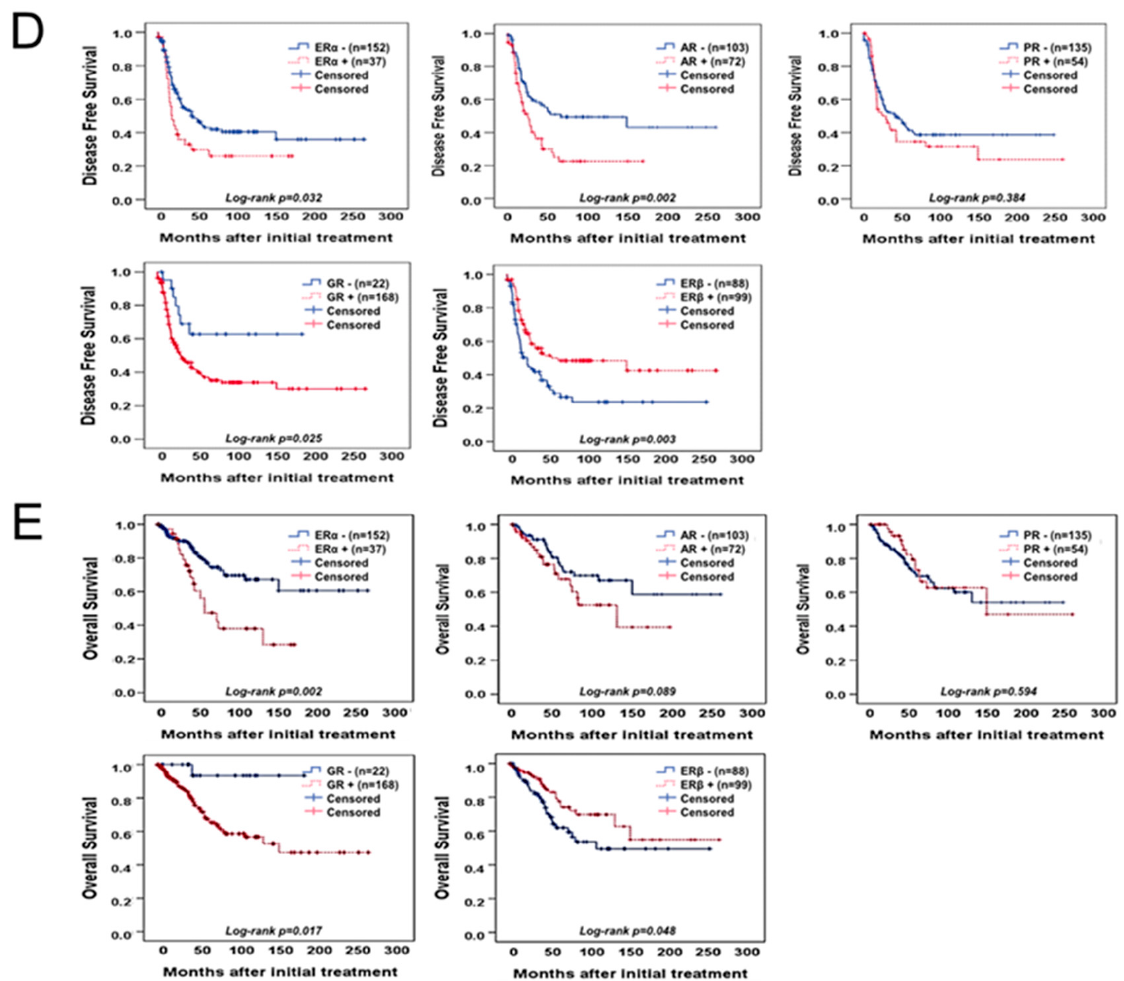
Figure 1. Expression of hormone receptors in EOC tissues. ( A ) Representative immunohistochemical staining images of ER α , AR, PR, GR, and ER β in nonadjacent ovarian epithelial tissues (Normal) and epithelial ovarian cancer (Cancer) tissue samples (scale bar: 50 µ m). ( B ) Boxplots of IHC staining data (histoscores) comparing between nonadjacent ovarian epithelial tissues (Normal) and epithelial ovarian cancer (Cancer) tissue samples of each hormone receptor subtype. Histoscores were calculated based on staining intensity and the area of positive staining ( C ) Publicly available data on the mRNA expression of ER α , AR, PR, GR, and ER β were obtained from the GEO data (GSE26712). A Mann–Whitney U-test or Kruskal–Wallis test was used to compare the mRNA expression level of each hormone receptor. ( D ) The DFS of patients with EOC depends on ER α , AR, PR, GR, and ER β expression. For the DFS analysis, 189 patients with EOC for ER α , 175 patients with EOC for AR, 189 patients with EOC for PR, 190 patients with EOC for GR, and 187 patients with EOC for ER β were included. ( E ) The OS of patients with EOC depends on ER α , AR, PR, GR, and ER β expression. For the OS analysis, 189 patients with EOC for ER α , 175 patients with EOC for AR, 189 patients with EOC for PR, 190 patients with EOC for GR, and 187 patients with EOC for ER β were included. The cut-off value of ER α was over 49.2 of the IHC score, cut-off value of AR was over 10.85 of the IHC score, cut-off value of PR was over 21.18 of the IHC score, and the cut-off value of GR was over 8.65 of the IHC score.